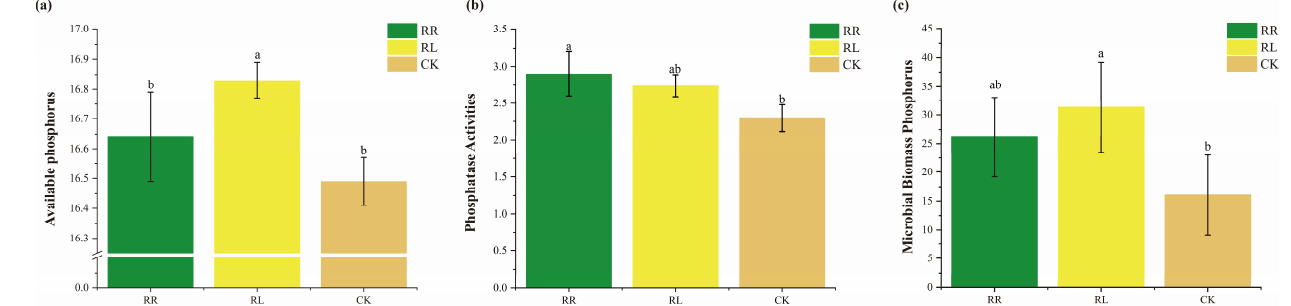
Figure 1. Available phosphorus concentrations ( a ), soil phosphatase activities ( b ) and soil microbial biomass phosphorus (MBP) ( c ) in the RR, RL and CK. All data are presented as the mean ± SD (standard deviation). Different letters in the column indicate significant differences among treatments at p < 0.05. Table 3. Soil bacterial alpha diversity in rhizospheres of oilseed rape under RR, RL and CK systems. Shannon Index